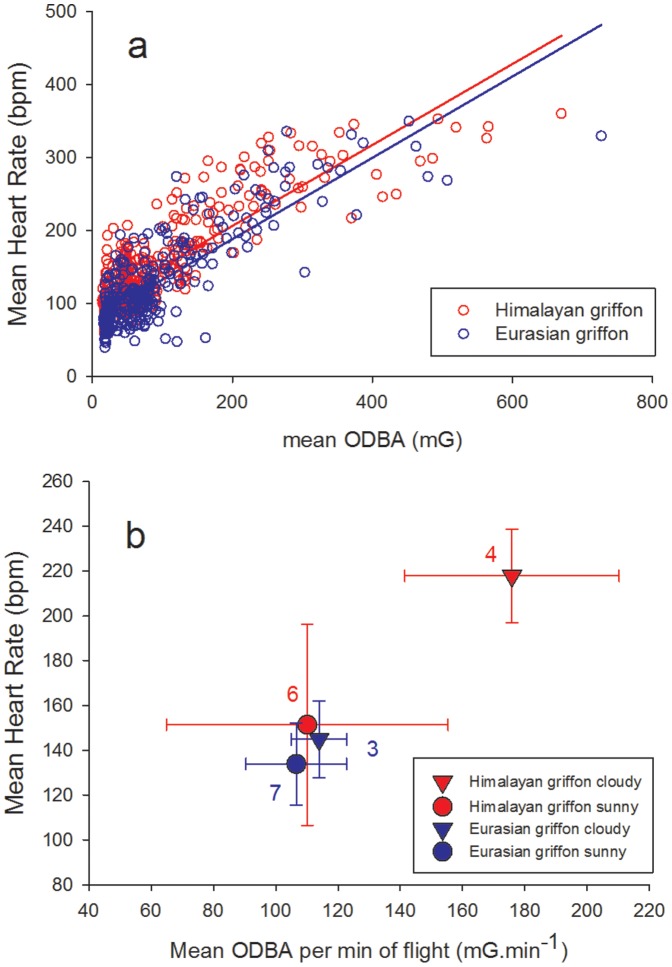
Correlation between heart rate and ODBA.Correlation between mean ± SD heart rate and Overall Dynamic Body Acceleration (ODBA) for the Himalayan (Himalayan griffon, red) and Eurasian griffon vultures (Eurasian griffon, blue): a) values averaged over one minute (including data from flight and from land (from TO-10 to LD+10); n = 382 min for Himalayan griffon and 337 min for Eurasian griffon). Regression lines are drawn in red for Himalayan griffon (R2 = 0.729) and in blue for Eurasian griffon (R2 = 0.688). b) values averaged over complete flights (TO to TO+17; no data from land), separating sunny (circles, 13 flights: 6 for Himalayan griffon and 7 for Eurasian griffon) and cloudy days (triangles; 7 flights: 4 for Himalayan griffon and 3 for Eurasian griffon).